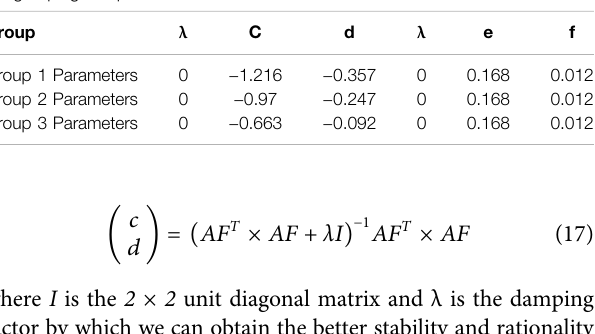
TABLE 2 | Parameters of the improved EREM model and C d path determined by the grouping samples.